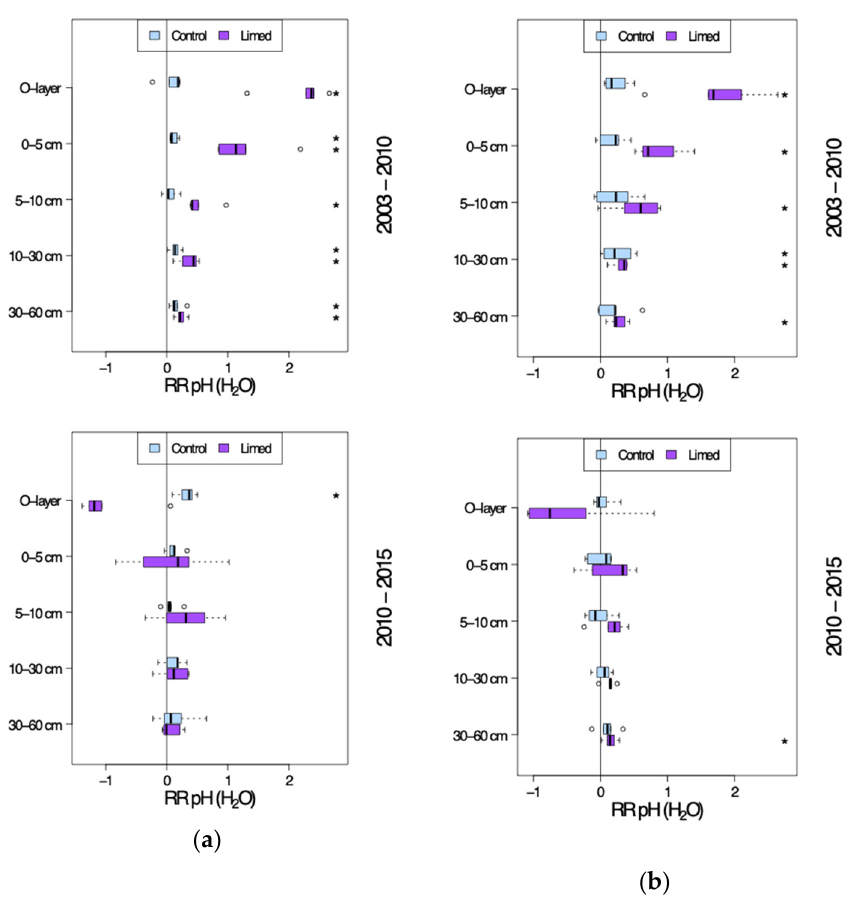
Figure 3. pH-H 2 O site average response ratio (RR a ) seven years after (2003–2010) and twelve years after the second lime treatment (2010–2015). ( a ) G1 study sites. ( b ) G2 study sites. *—significant differences between current and previous sampling